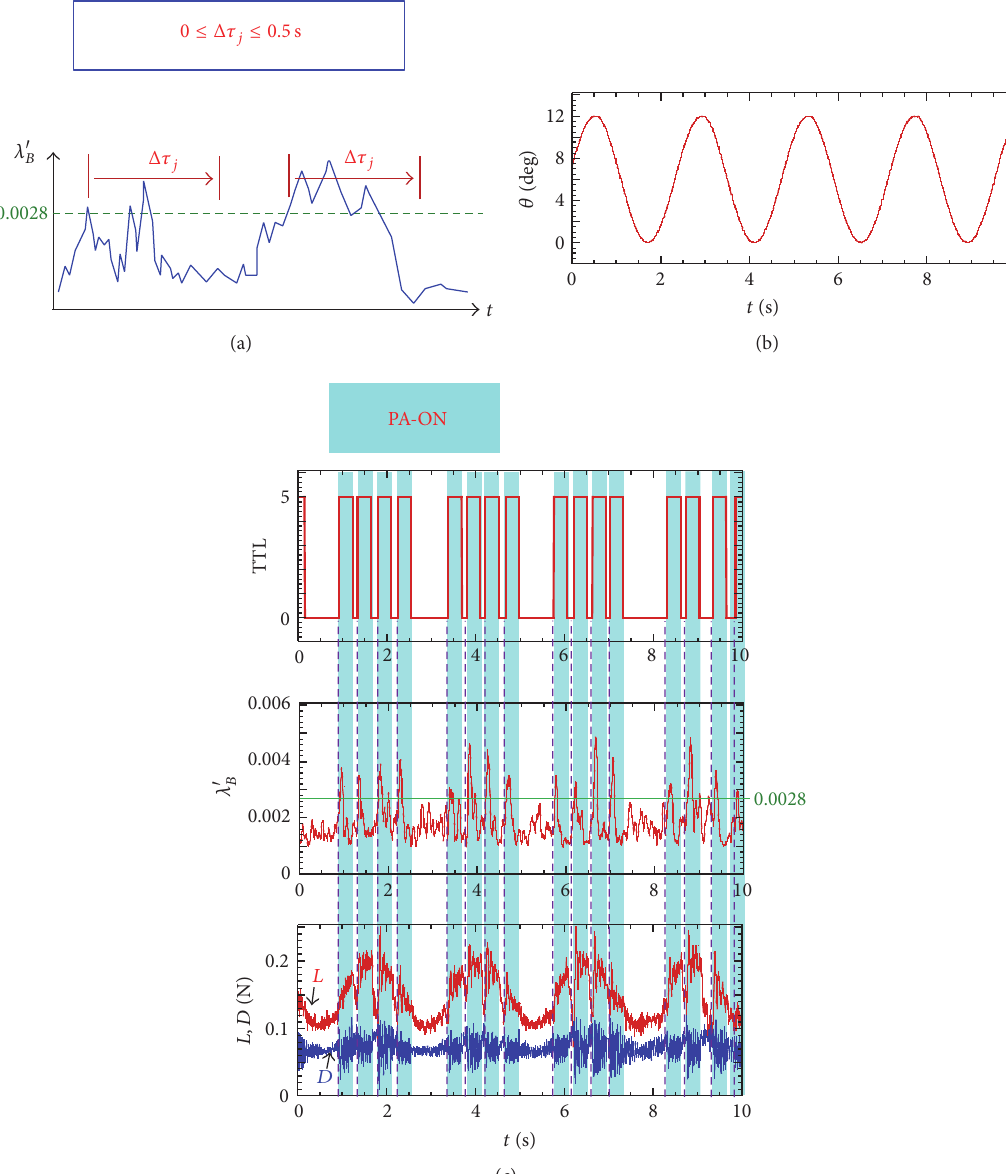
Figure 14: Flow separation control effects of the feedback system under periodic wall oscillation. (a) Duration ( 𝛿𝜏 𝑗 ) for inducing tangential jets from the exposed electrode of the string-type DBD plasma actuator, once the running 𝜆 󸀠 𝐵 crossed the threshold value. (b) 𝜃 variations under periodic wall oscillation. (c) Time-series for TTL, 𝜆 󸀠 𝐵 , 𝐿 , and 𝐷 over 10s in case of Δ𝜏 STD = 0.05 s. Jets induced by the DBD plasma actuator are injected for Δ𝜏 𝑗 = 0.3 s beginning when 𝜆 󸀠 𝐵 crossed 𝛾 . 𝐿 increases immediately when 𝜆 󸀠 𝐵 exceeds 𝛾 , and then 𝜆 󸀠 𝐵 returns to below 𝛾